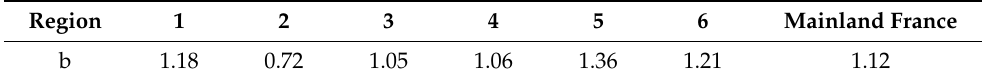
Table 5. b-values computed by regressing GR law (Equation (10)) on FMD of main shocks observed in instrumental seismicity for each SHARE region. Region numbers refer to Figure 4. See Appendix B for more